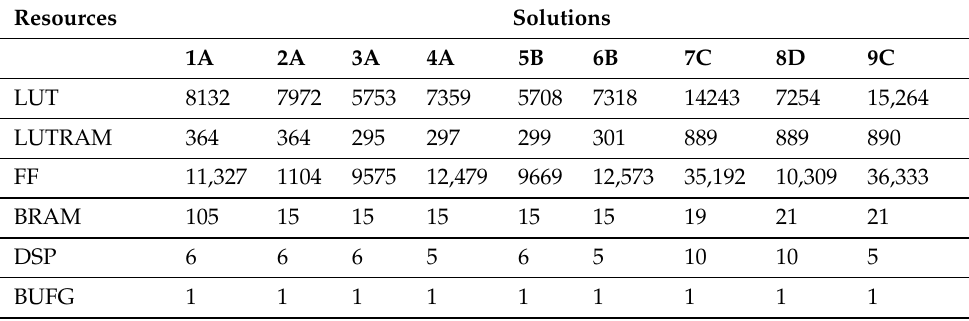
Table 1. ANN PE FPGA